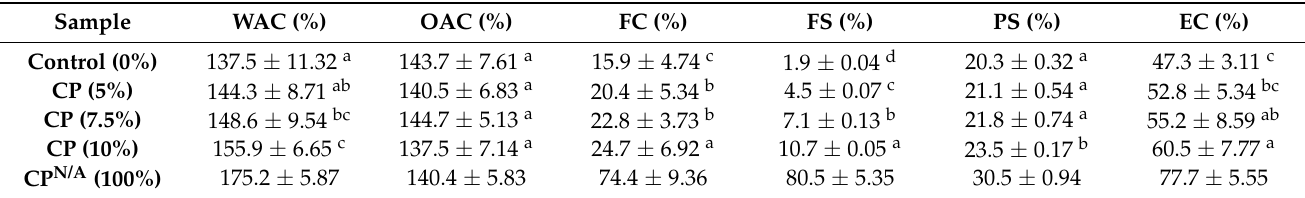
Table 3. Functional properties of wheat flour with cricket powder replacement levels.